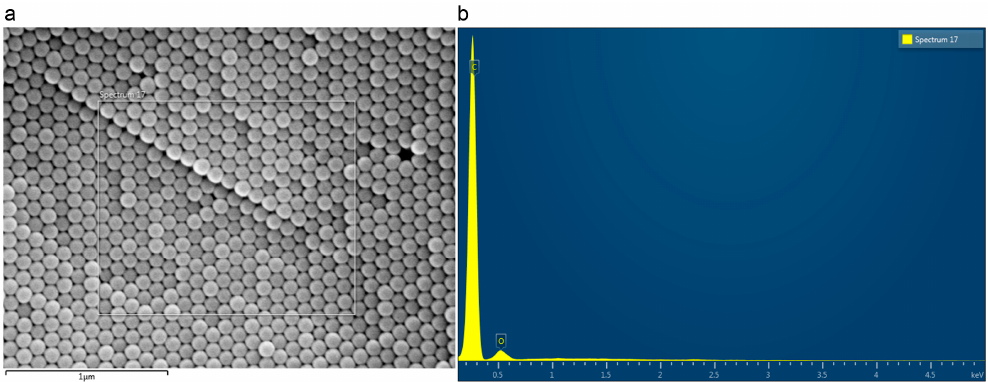
Figure 7. Energy dispersive x-ray analysis (EDX spectroscopy) analysis of polystyrene nanoparticles (PNPs) to characterize elemental composition, area of sample ( a ) and relative elemental spectrum ( b